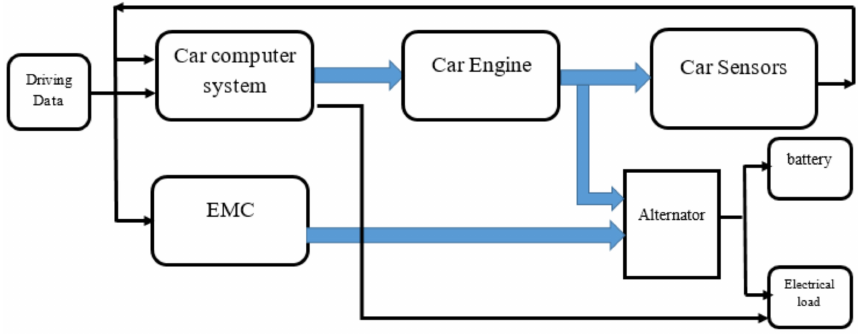
Figure 12. Energy management controller for the vehicle “Reprinted from [16]”.